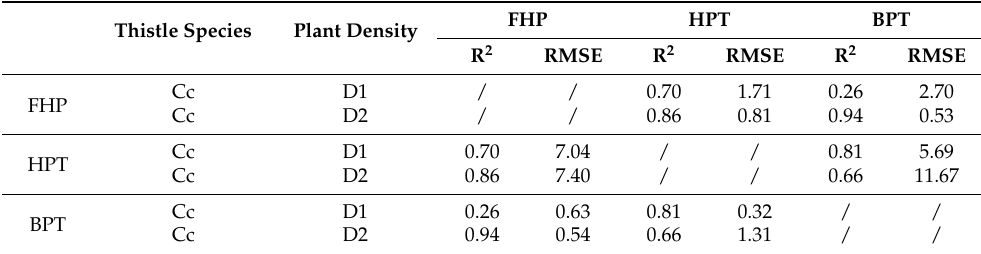
Table 8. Coefficient of determination and root mean square error (RMSE) of the linear relationship between the number of flower heads per plant (FHP), plant height (HPT) and number of branches per plant (BPT) on Cynara cardunculus L. (Cc) at two plant densities compared. Thistle